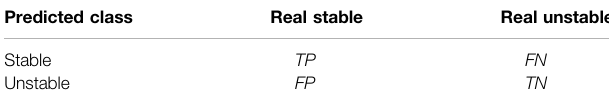
TABLE 3 | Confusion matrix for TSA classi fi